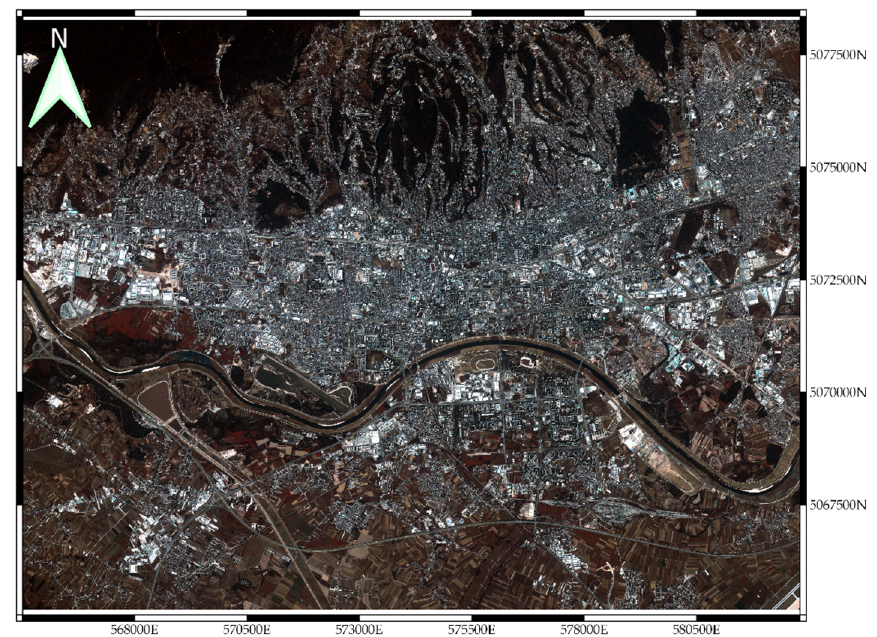
Figure 1. City of Zagreb: RGB composition of WorldView-2 imagery [38] .